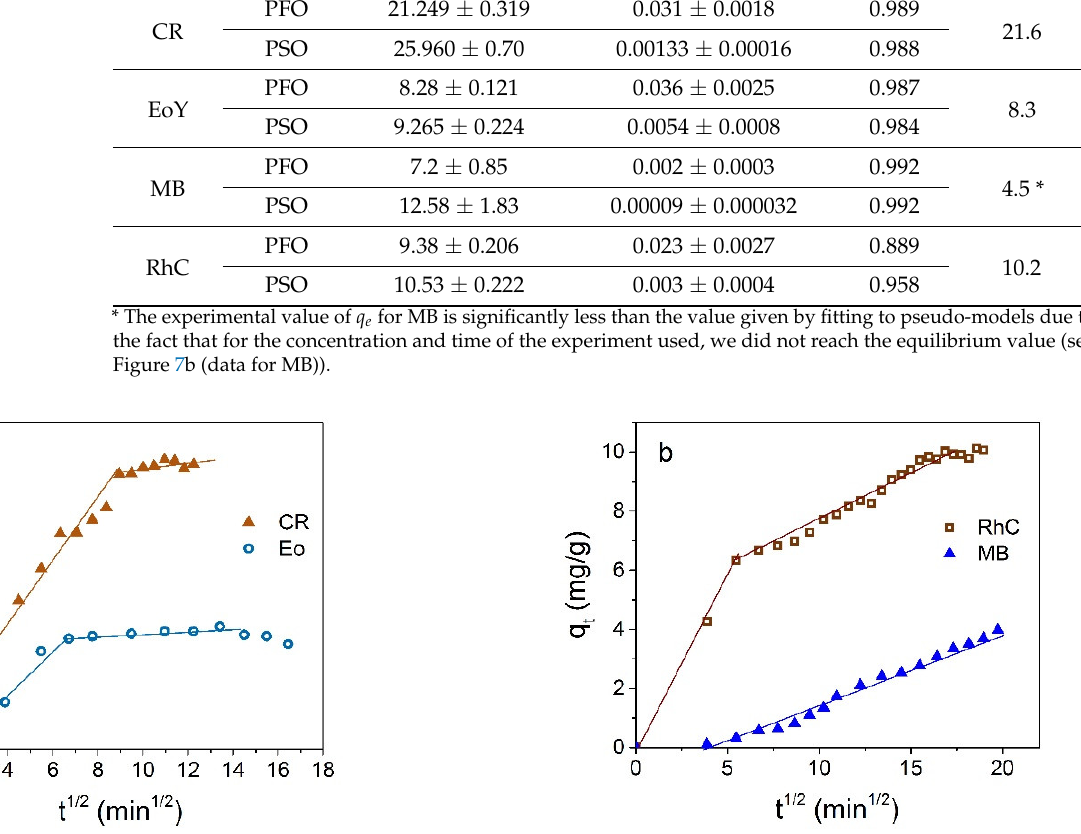
Table 1. Parameters of the best nonlinear fit to the pseudo-first- and pseudo-second-order kinetic models of adsorption data for Fe 3 O 4 NPs, for experimental conditions of 25 ◦ C, C 0 = 60 mg/L for CR and C 0 = 30 mg/L for other dyes, and m (NPs) ≈ 3 mg in V = 1.5 mL. Parameters of the Nonlinear Fit Experiment Kinetic Dyes Model